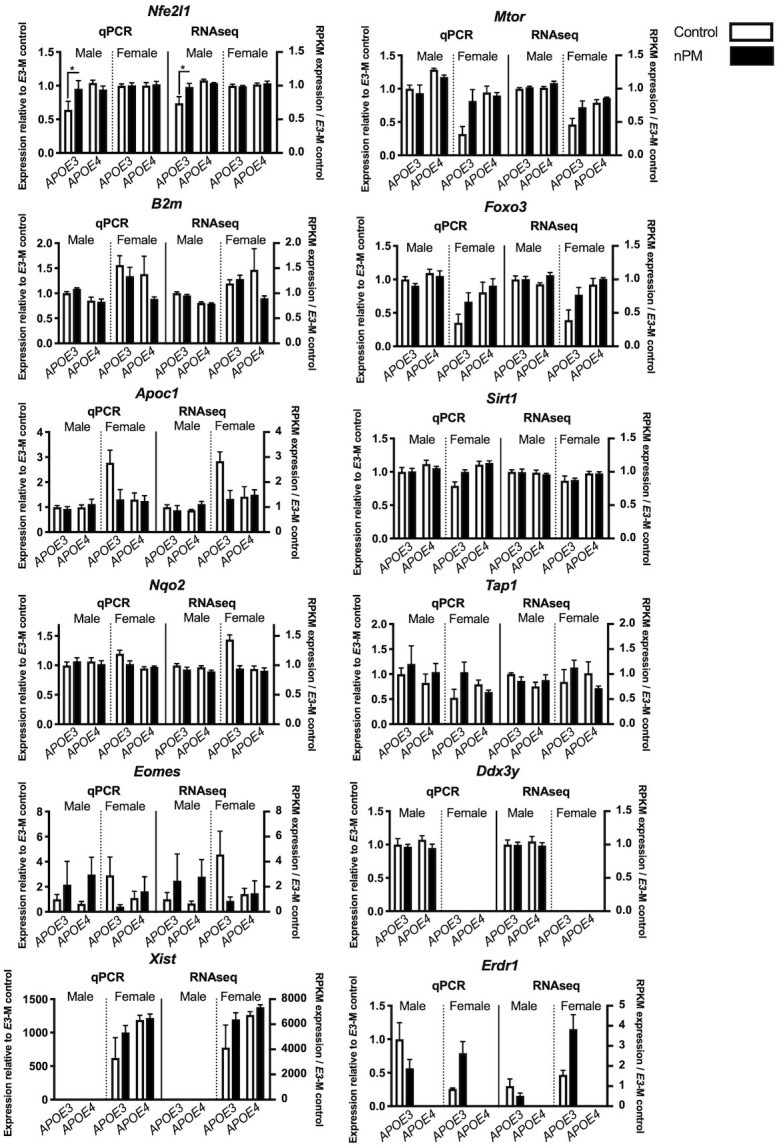
qPCR validation of selected genes from RNAseq, with GAPDH as reference gene, showing similar direction and scale of response to nPM by qPCR and.Three-way interaction of qPCR and RNAseq shows high overlap of significant factors. Mean ± SE.